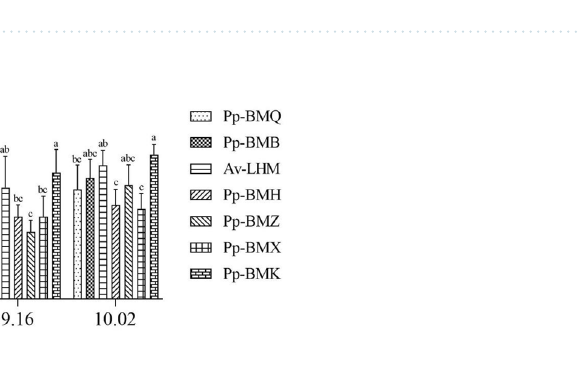
Figure 7. The incidence of seven ecotypes stem necrosis lesions disease caused by B. exigua var. rhapontica in 2021 in the field.